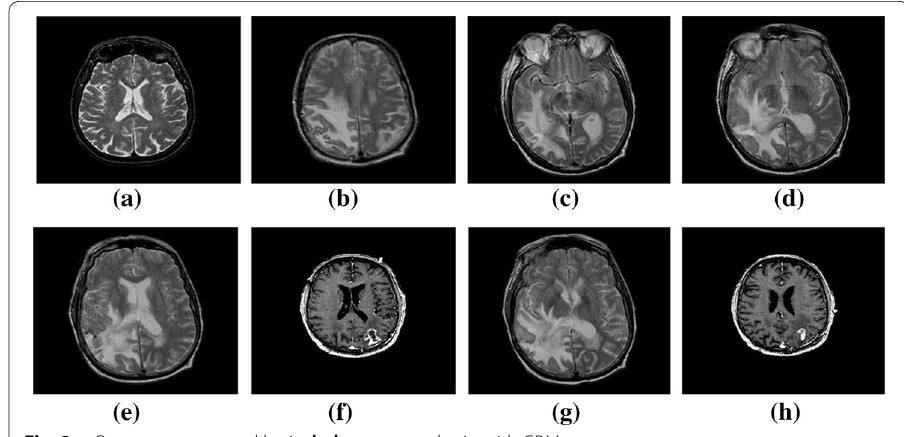
Fig. 2 a Represents a normal brain. b – h represents brain with GBM